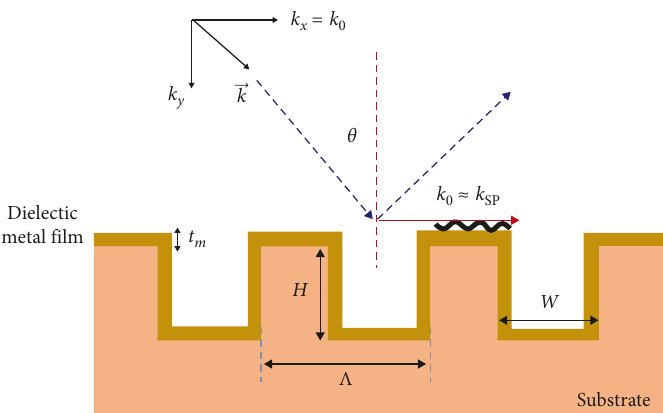
Figure 1: A schematic diagram of the one-dimensional rectangular metal coated grating where Λ is the grating period, W is the grating width, H is the grating depth, and t m is the metal thickness. SPR occurs on the metal-dielectric interface when the wave vector of the incident ) is coupled to the wave vector of surface wave ( k wave ( k 0